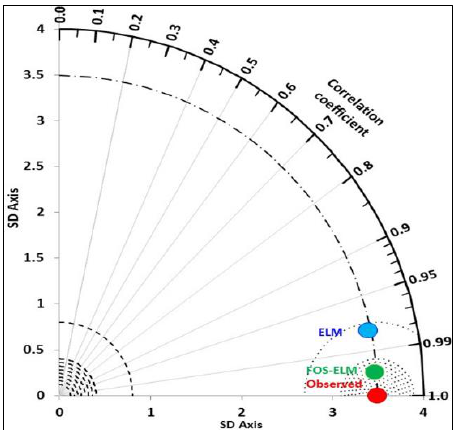
Figure 7. Two dimensions Taylor diagram illustration for the best input combination: xvariable forgetting factor (FOS-ELM) vs. extreme learning machine (ELM).